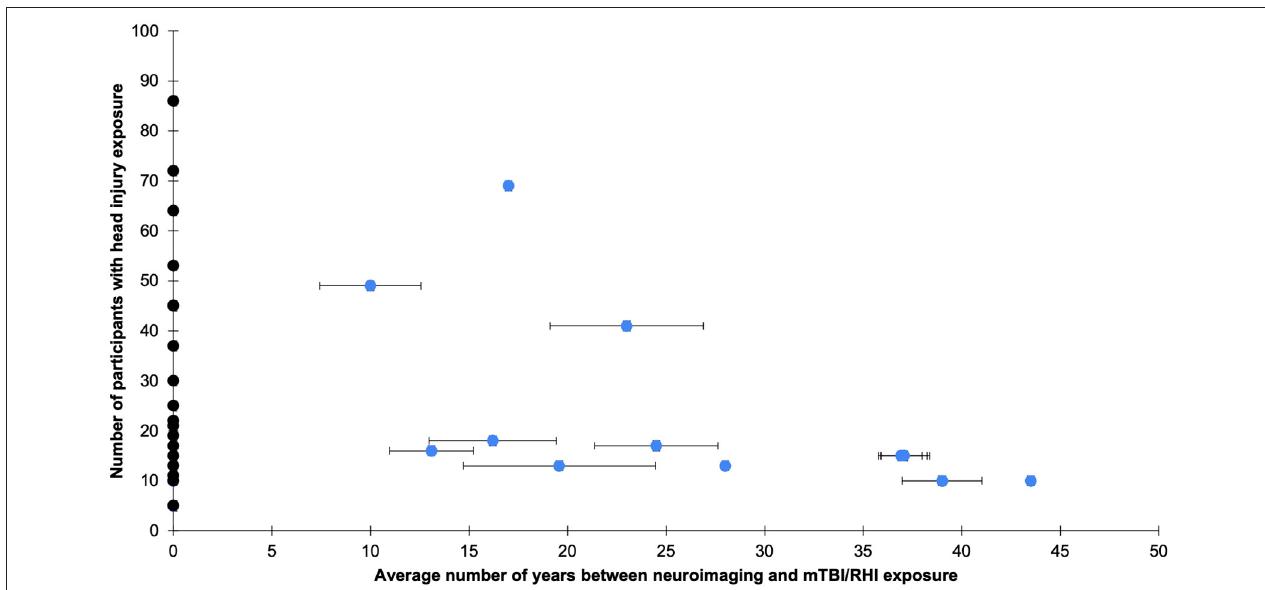
FIGURE 2 | The average years since head injury exposure and number of participants with head injury exposure per study. Bars indicate the standard error and were plotted where available. Black dots represent studies that did not explicitly state years since head injury exposure but used other estimates, such as years since playing sport, or met criteria because follow-up occurred at least one decade after exposure to sport. See Supplementary Tables 1–3 for more